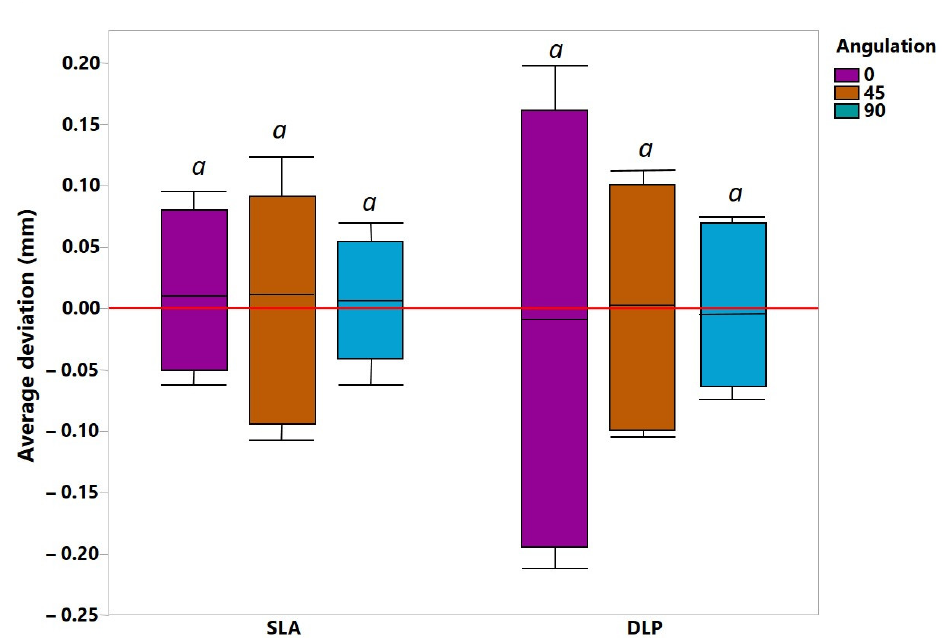
Figure 6. The mean average deviations between various study groups over the whole intaglio surface. a represents level of statistical significance.